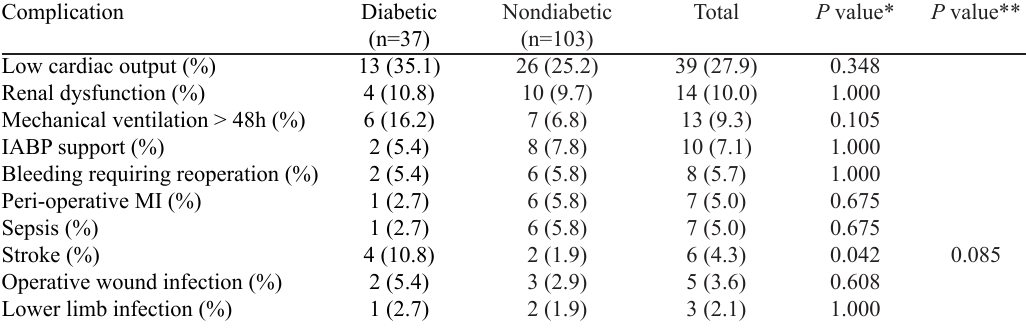
Table 3. Comparison of diabetic and nondiabetic patients for the occurrence of postoperative morbidity.